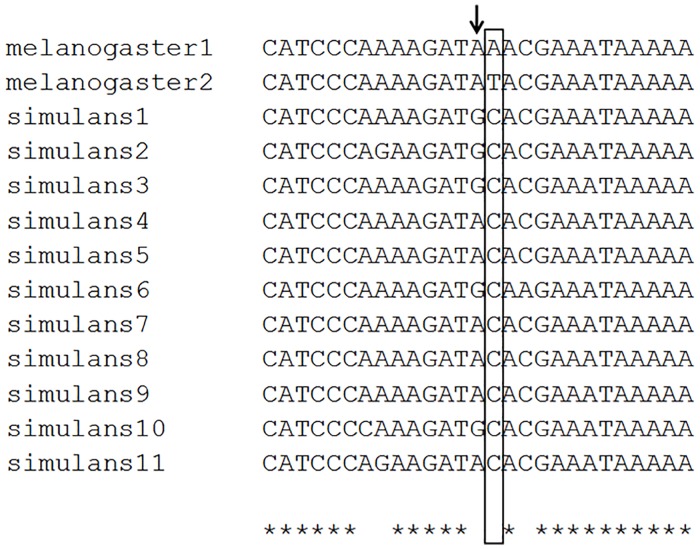
Nucleotide alignment of the cpo region in D. melanogaster and D. simulans.D. melanogaster sequences, top two rows. The box indicates the position of SNP cpo48034(A/T) which appears to be monomorphic in D. simulans. The arrow points to a position which is polymorphic in D. simulans but not in D. melanogaster.